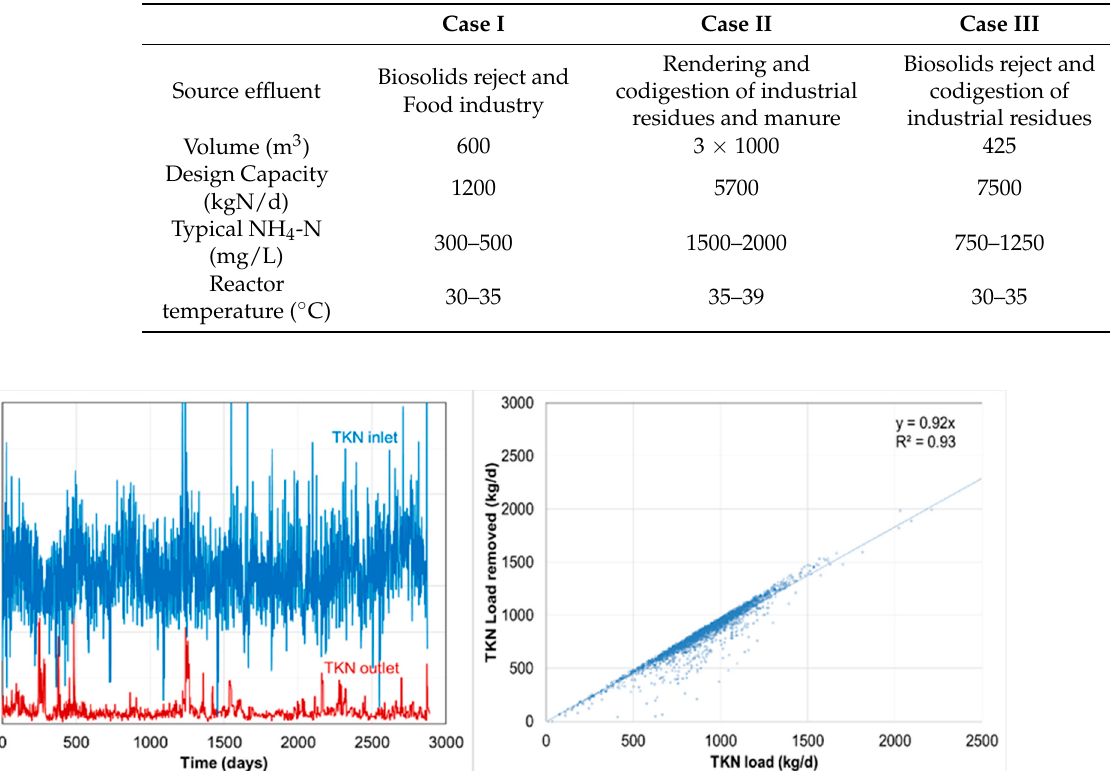
Table 2. Characteristics of the long-term case studies discussed.